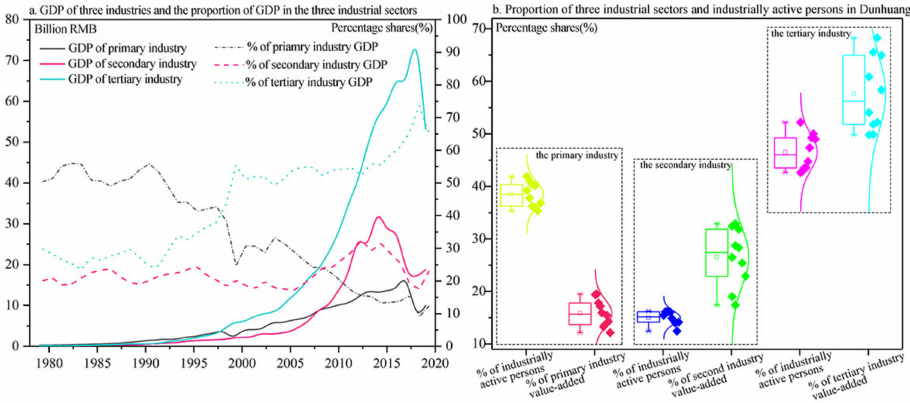
Figure 4. The industrial structure and transformation in Dunhuang.